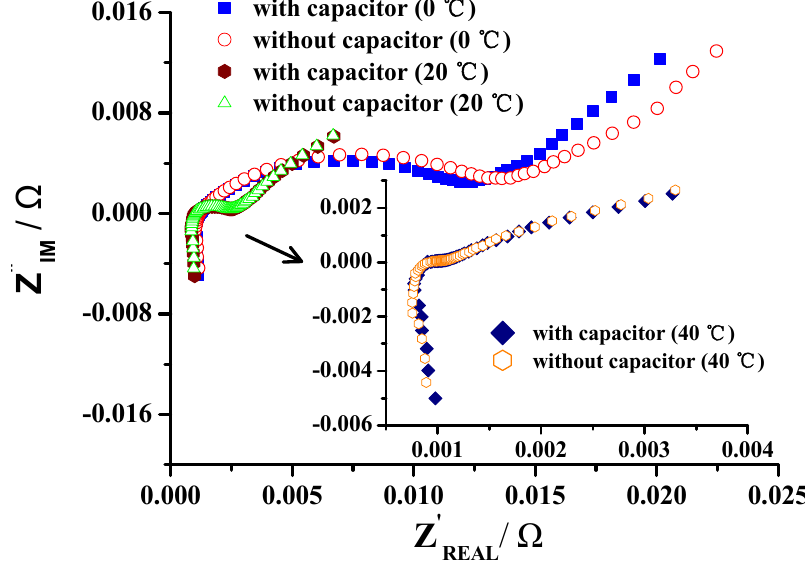
Figure 16. EIS curves of the battery with and without capacitor at 0, 20 and 40